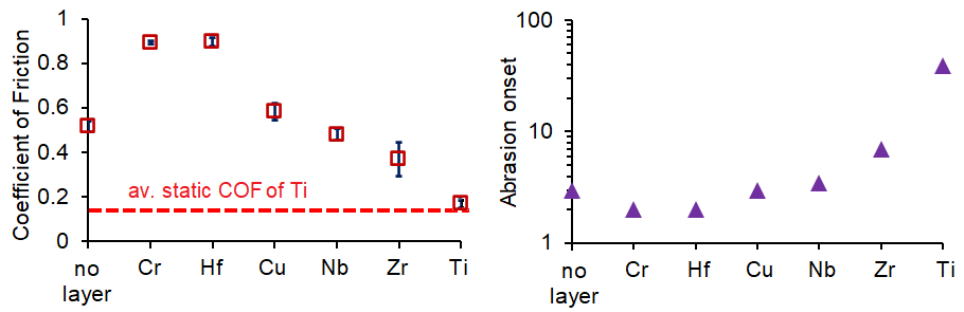
Figure 6. Influence of 75 nm layers on static friction after 10 cycles ( left ) and abrasion onset dynamic friction ( right ) on anodized 6082 alloy.